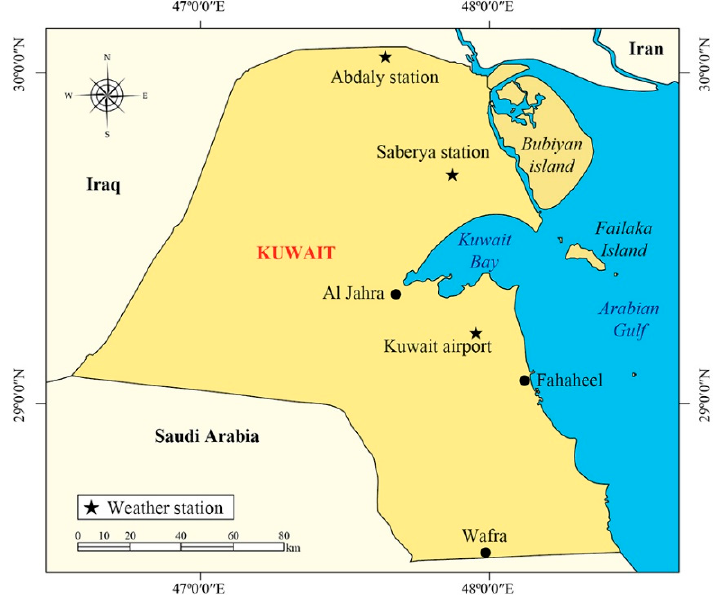
Figure 1. Study area map and locations of the Kuwait International Airport (KIA), Abdaly, and Saberya weather stations.